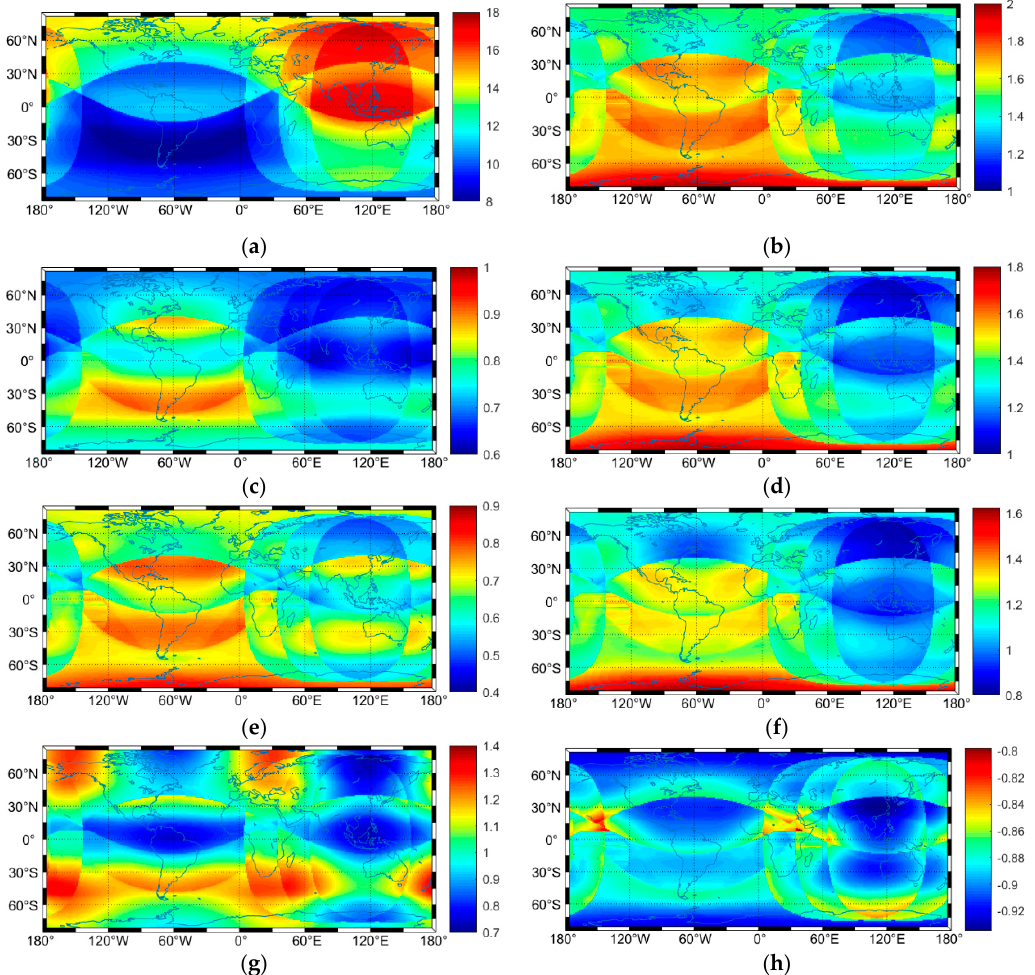
Figure 8. Estimated DOPs, positioning precision in longitude versus latitude, and the correlation between station height and receiver clock difference of the BDS-3+HEO constellation. ( a ) Number of visible satellites; ( b ) GDOP; ( c ) HDOP; ( d ) PDOP; ( e ) TDOP; ( f ) VDOP; ( g ) The ratio of positioning precision between the longitude component and the latitude component; ( h ) Correlation level between station height and receiver clock difference.